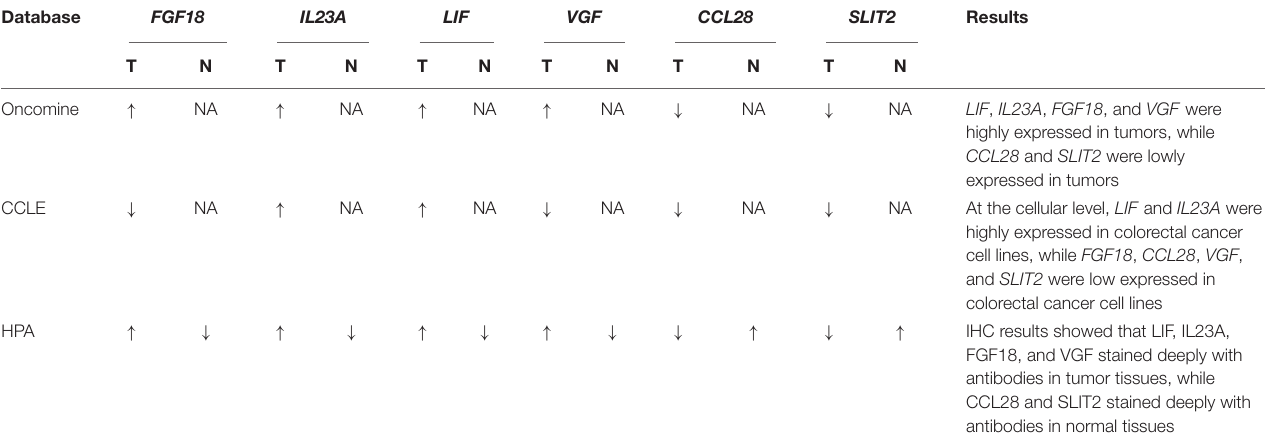
TABLE 3 | Summary of multidimensional external validation results based on multiple databases.